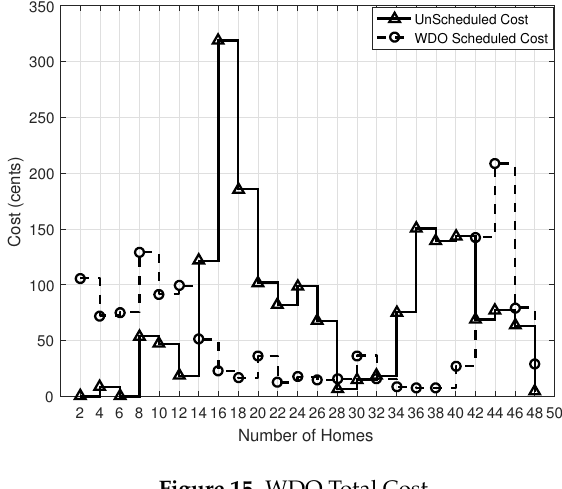
Figure 15. WDO Total Cost.